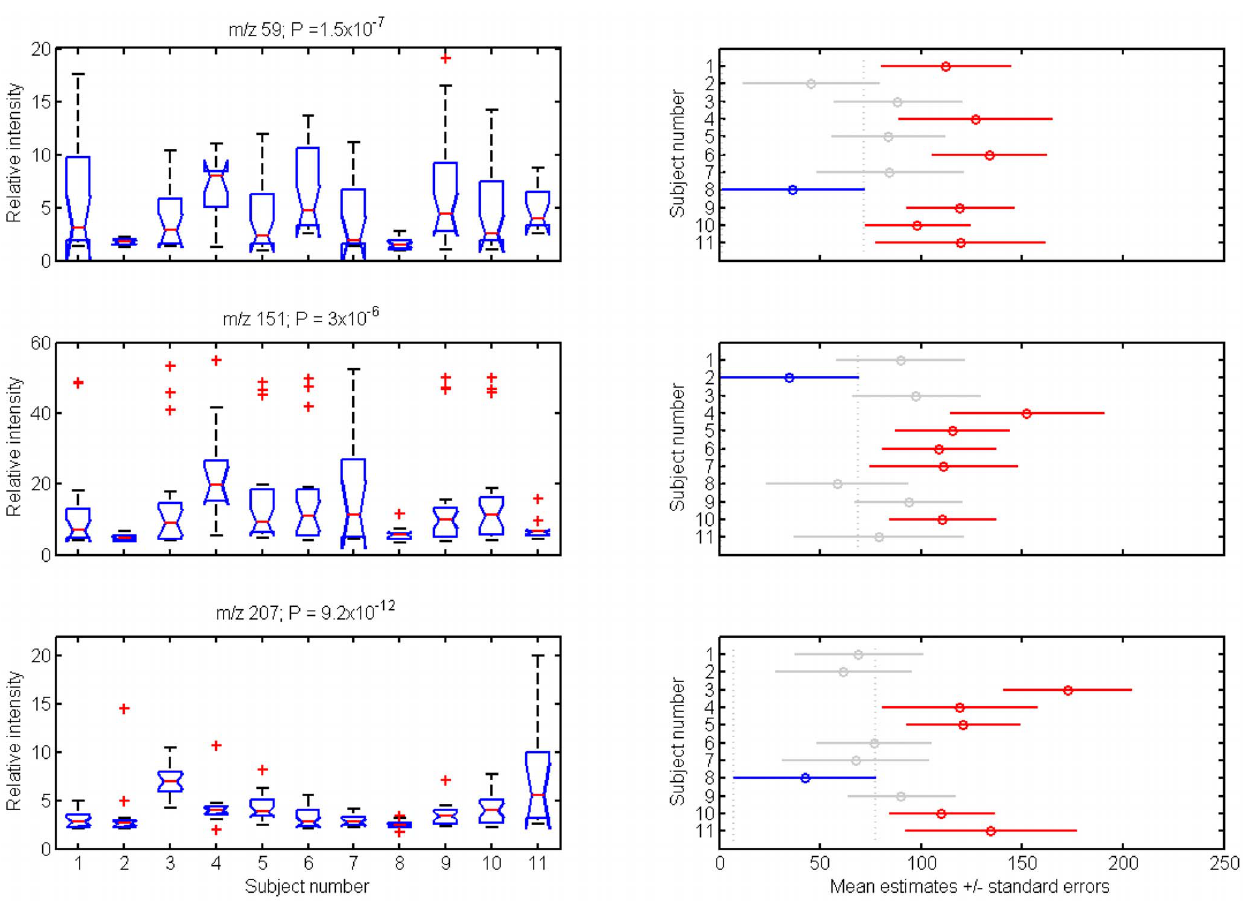
Figure 2. Temporal variability of the three compounds shown in figure 1 over the nine days of measurements for the eleven subjects (left). The central mark of each box corresponds to the median, the edges of the box are the 25 th and 75 th percentiles, the whiskers extend to the most extreme data points not considered outliers, and outliers are plotted individually (beyond + /–2.7 s ). The P values resulting from the Kruskal-Wallis test are quoted on top of the box-plots. Further multicomparison tests (right) showed that, with some exceptions, in most of the cases inter-subject variability was not significantly different (overlapping intervals).